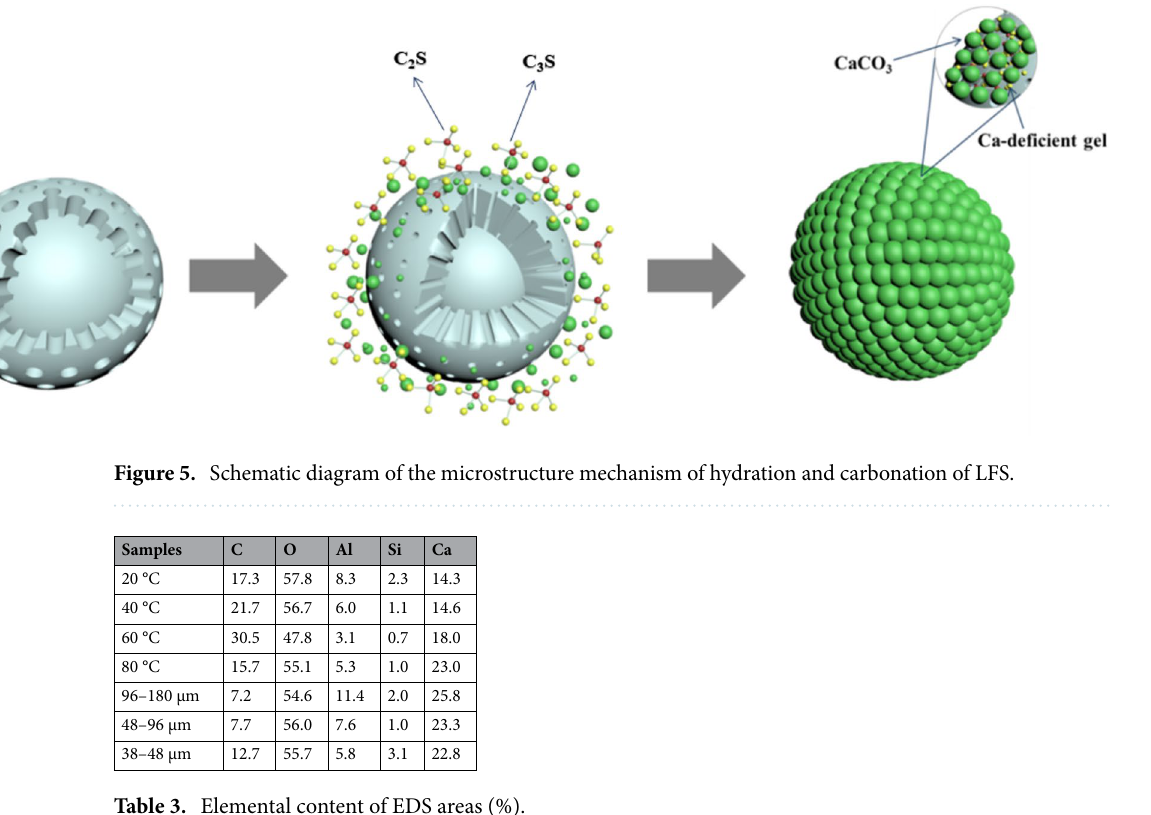
Table 3. Elemental content of EDS areas